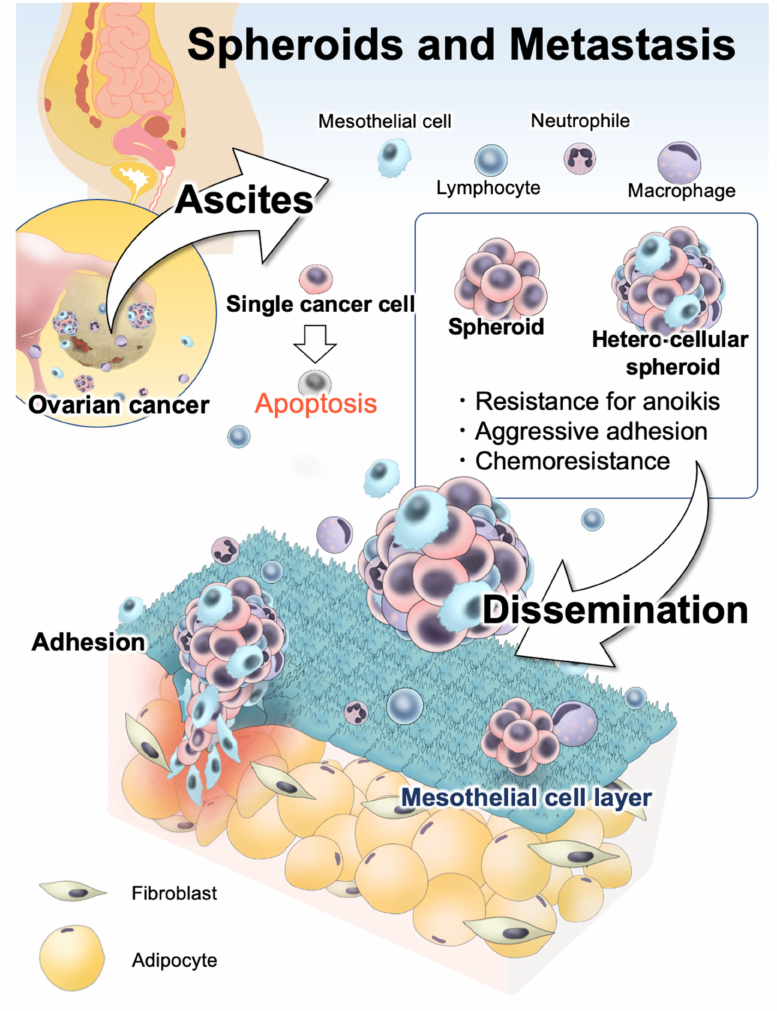
Figure 2. Image of EOC cells in ascites detached from primary cite. The microenvironment in ascites is complex and dynamic. EOC cells form spheroids for surviving anchorage-independent conditions, the ability to adhere to the mesothelial layer, and resistance to chemotherapy. In ascites, multiple types of non-malignant cells, including mesothelial cells, lymphocytes, neutrophils, and macrophages, support EOC metastasis. Some of EOC spheroids are composed of not only EOC cells but also non-malignant cells. These hetero-cellular spheroids are reported to be more aggressive in their abilities for adhesion and